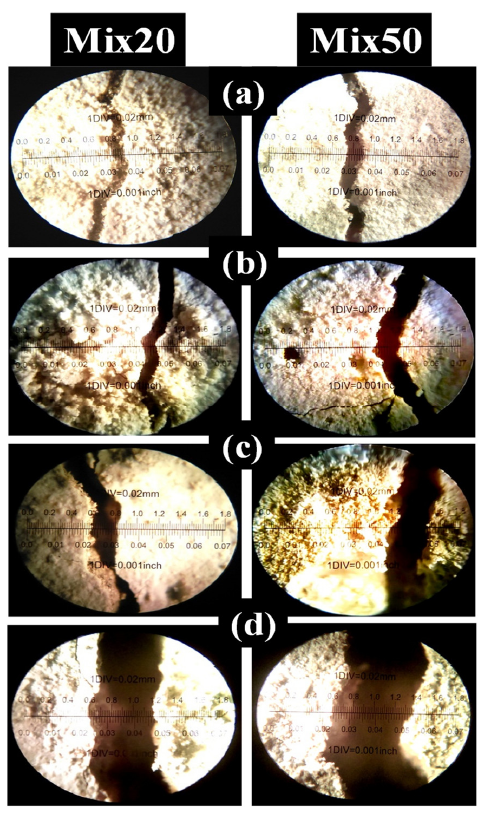
Figure 11. Crack width of concrete specimens exposed to elevated temperatures: ( a ) 30, ( b ) 60 min, ( c ) 90, and ( d ) 120 min. ( c ) 90, and ( d ) 120